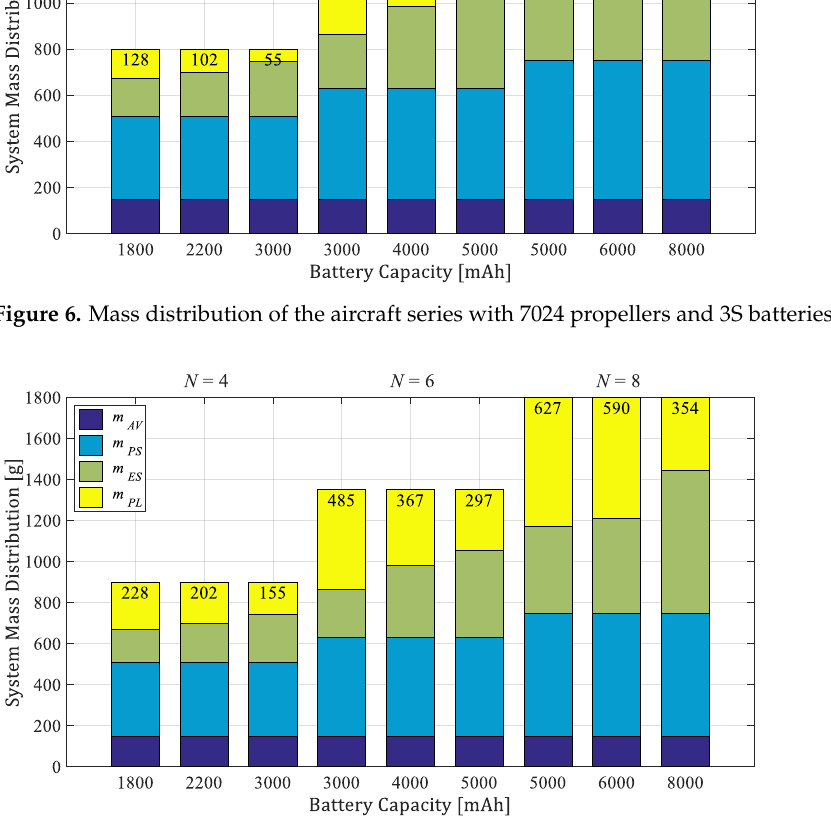
Figure 7. Mass distribution of the aircraft series with 8027 propellers and 3S batteries (TWR = 1.7).